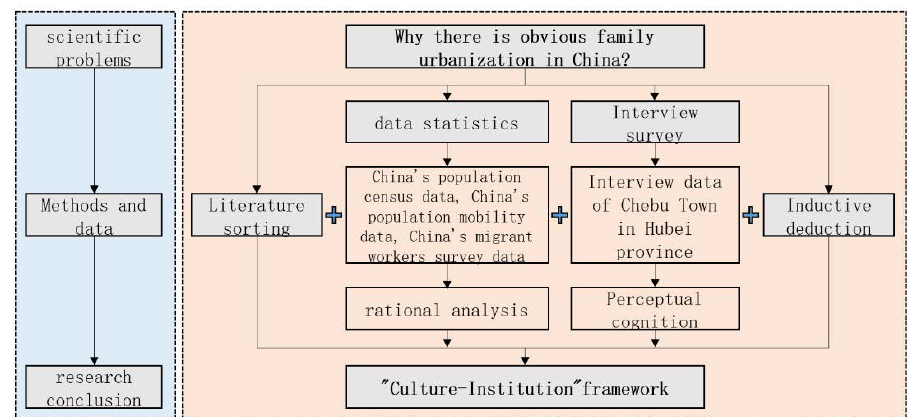
Figure 3. The research framework of this paper.